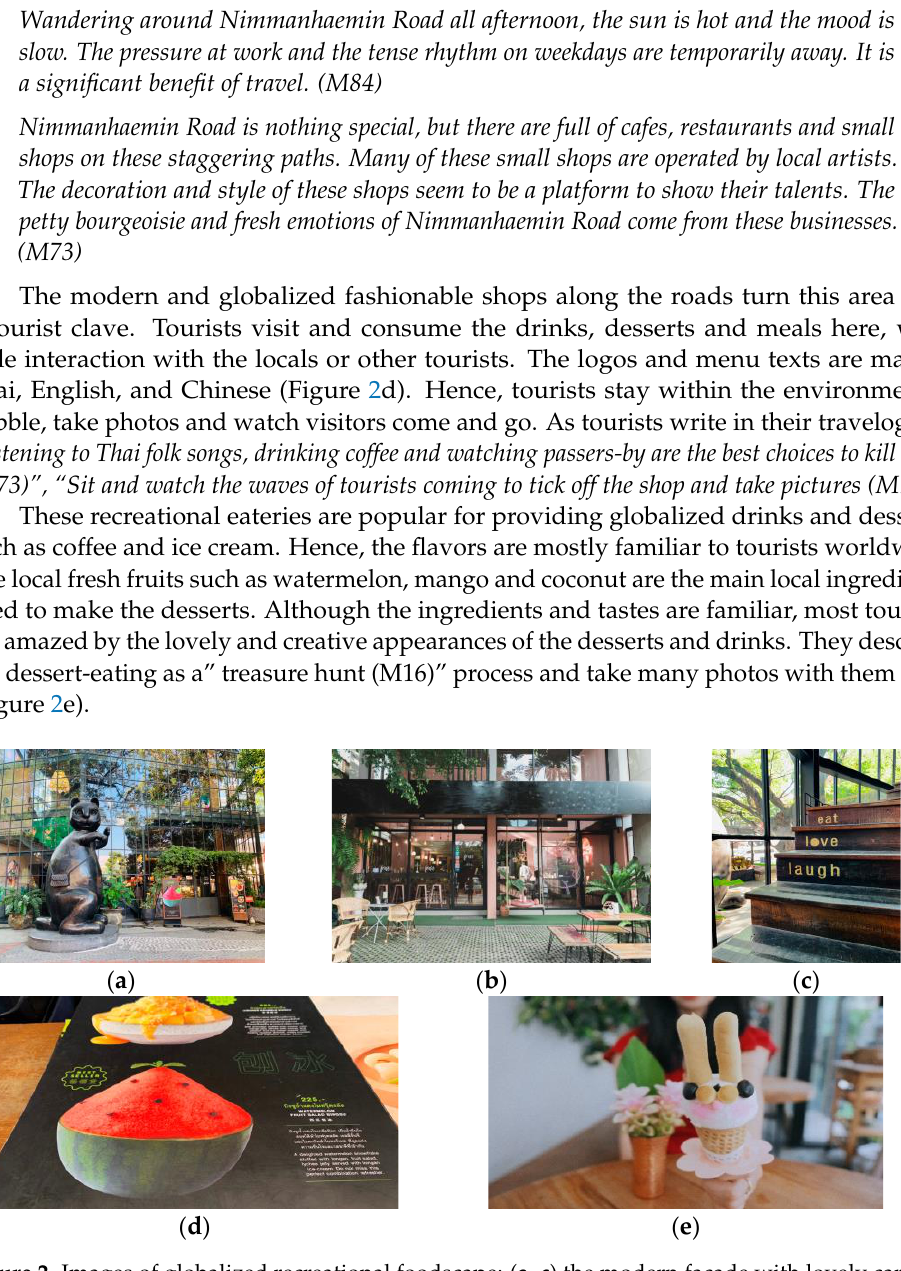
Figure 2. Images of globalized recreational foodscape: ( a – c ) the modern facade with lovely cartoon models; ( d ) the menu with Thai, English, and Chinese languages; ( e ) tourists taking photos with the creative and lovely desserts used with permission (this applies to Figures